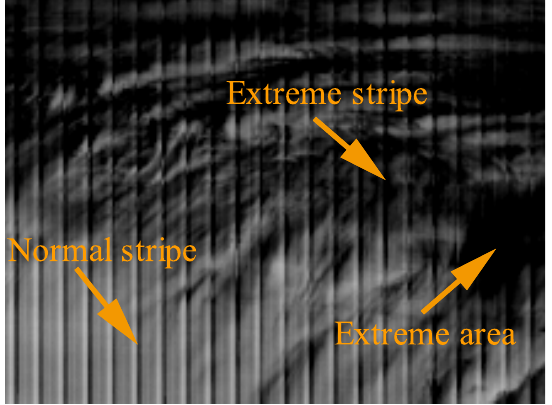
Figure 3. Illustration of Extreme Stripe and Extreme